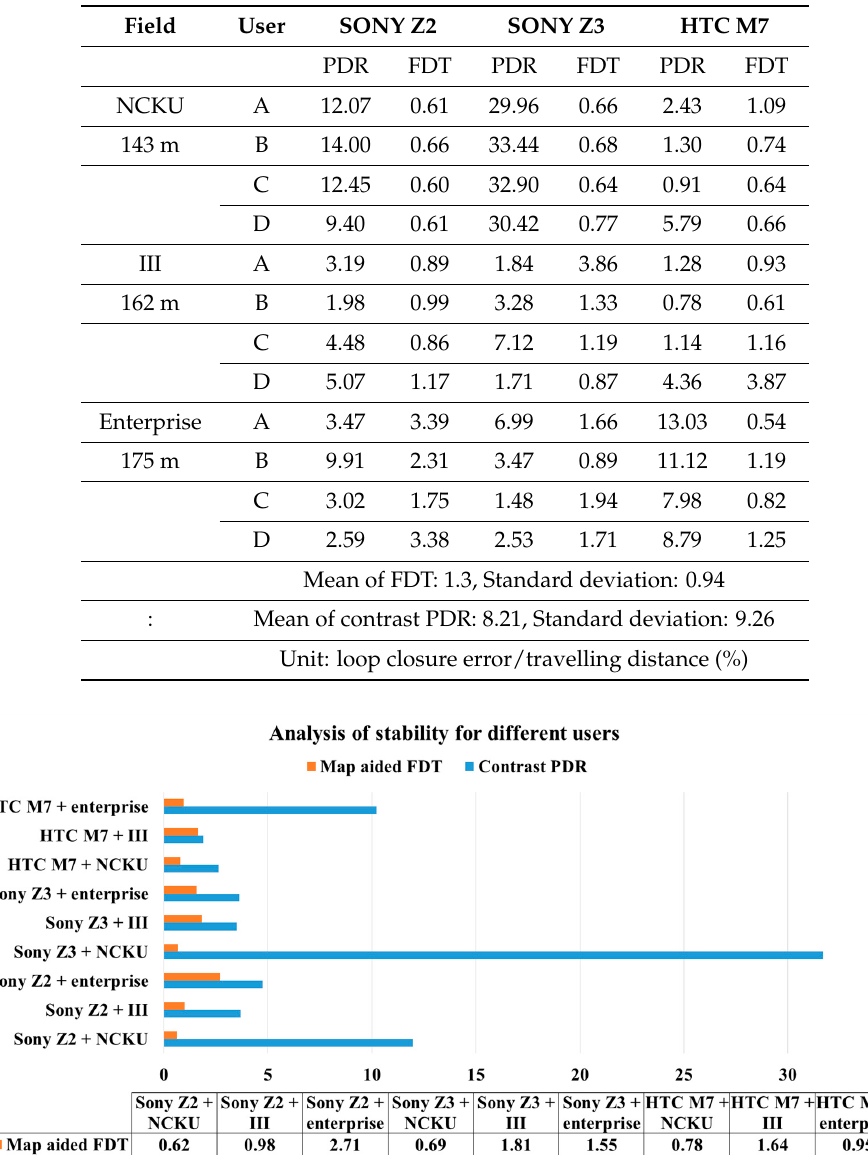
Table 5. The accuracy of FDT and contrast PDR system.